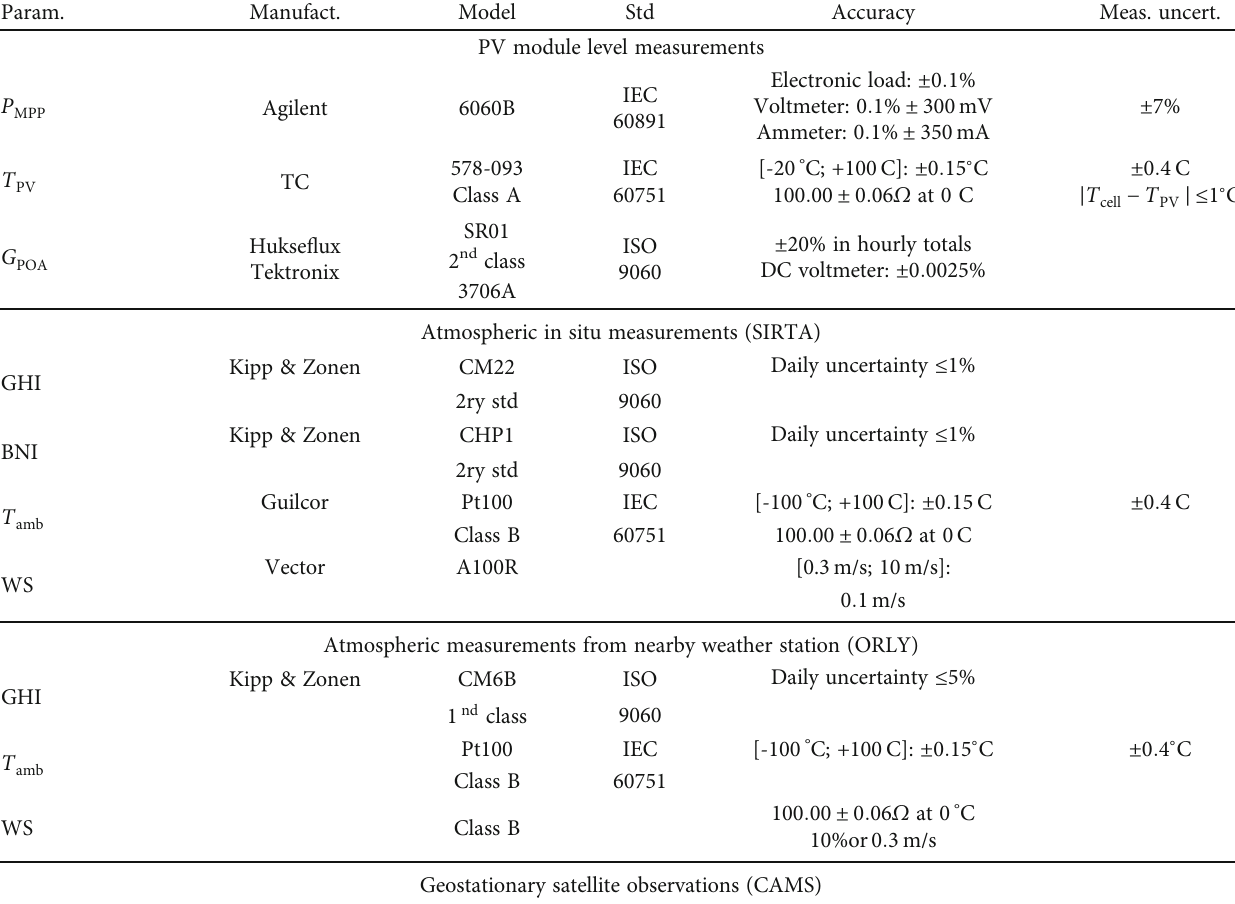
Table 4: Equipment and sensors used for all the presented measurements.